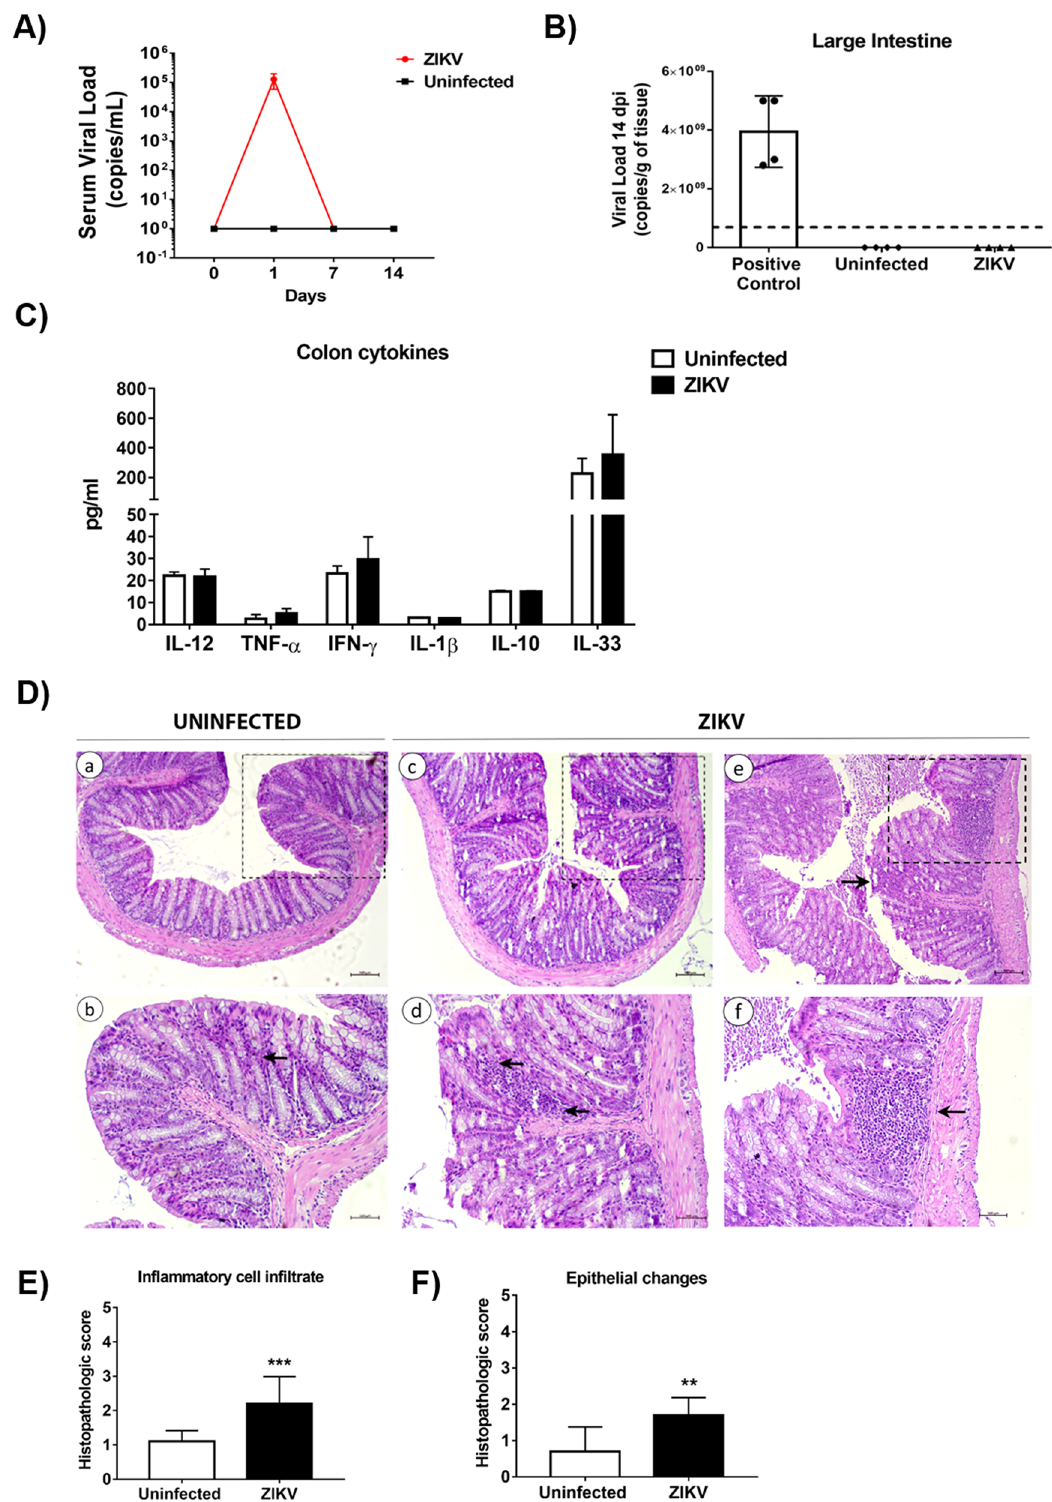
Figure 4. Microbiota changes induced by ZIKV infection cause intestinal epithelium damage and intense leukocyte recruitment to the gut colon in adult immunocompetent mice. C57BL/6J mice (N = 5) were infected with ZIKV and colon tissue was collected after 14 days post-infection. The viral titer was assessed by qPCR in the serum ( A ) and the colon ( B ). The secretion of pro-inflammatory cytokines IL-12, TNF-α, IFN-γ and IL-1β, anti-inflammatory cytokines IL-10, and the cytokine IL-33, was measured by ELISA ( C ). The histological morphology of the colon was analyzed by HE staining and acquired in Zeiss microscope ( D ). Da-b represent section from uninfected mice and Dc-f represent sections from ZIKV infected mice. Db, Dd, and Df present zoomed area from Da, Dc, and De, respectively. Leukocyte infiltration and damaged epithelium are indicated by black arrows. Histological score comparing uninfected and ZIKV mice. The score represents the inflammatory cell infiltration ( E ) and epithelial changes ( F ). Statistical analyses were performed using a Student’s two-sample t-test, the non-parametric p-values were calculated with the Mann–Whitney test. Graphic bars represent a confidence interval of 95% (*p < 0.05; **p < 0.01 ***p <